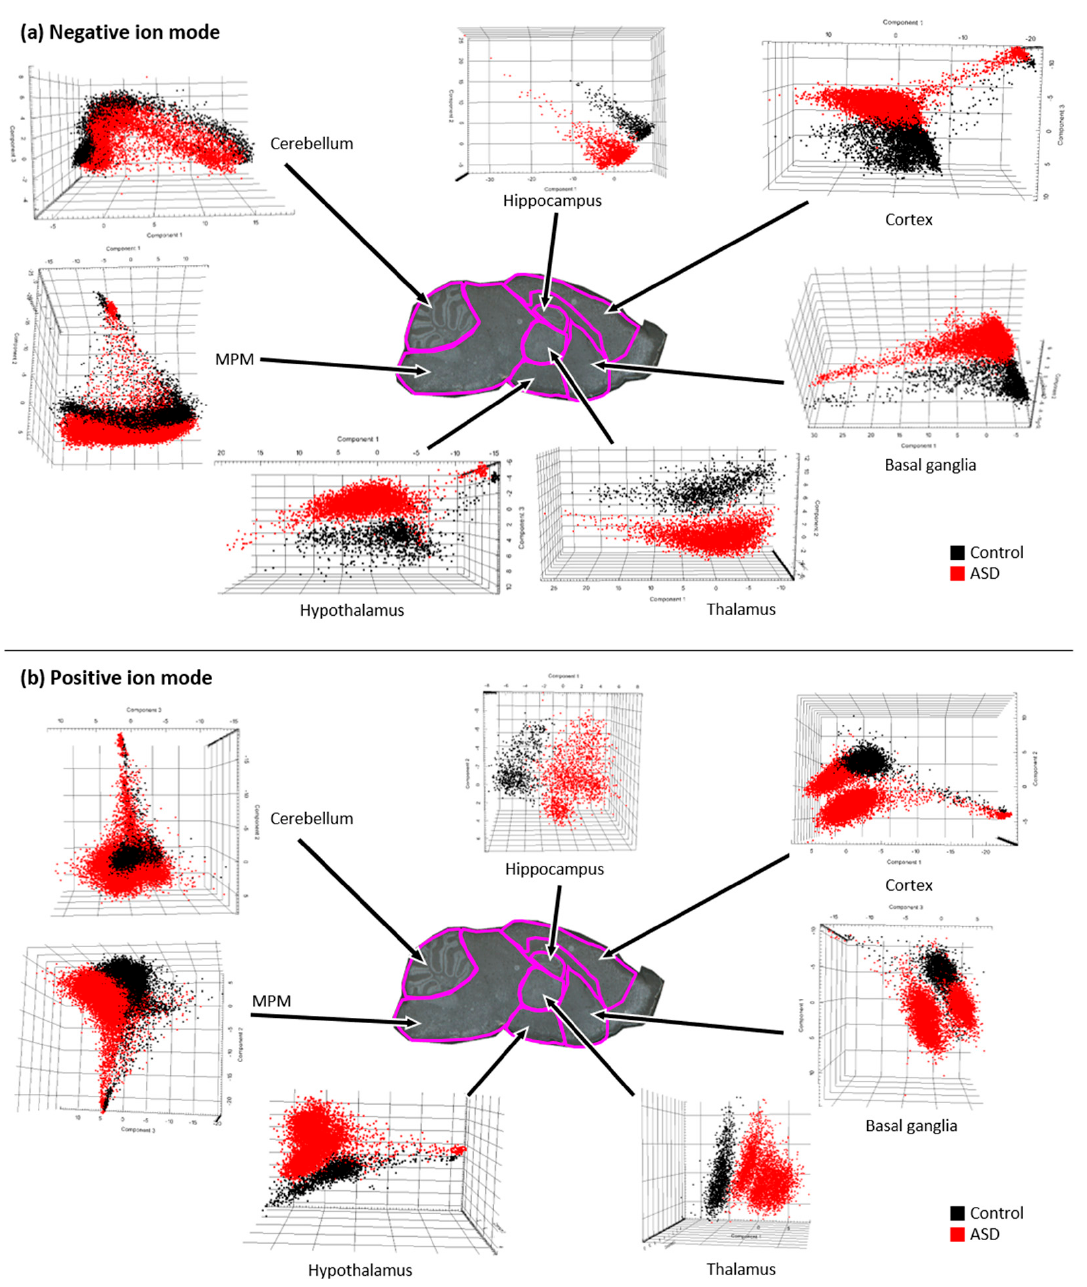
Figure 5. Three − dimensional principal component analysis score plots from seven brain regions in valproic acid-induced autism spectrum disorder (ASD) and control mice. Three − dimensional plots show three component scores obtained from individual spectra of negative ions ( a ) and positive ions ( b ) measured in seven brain regions.